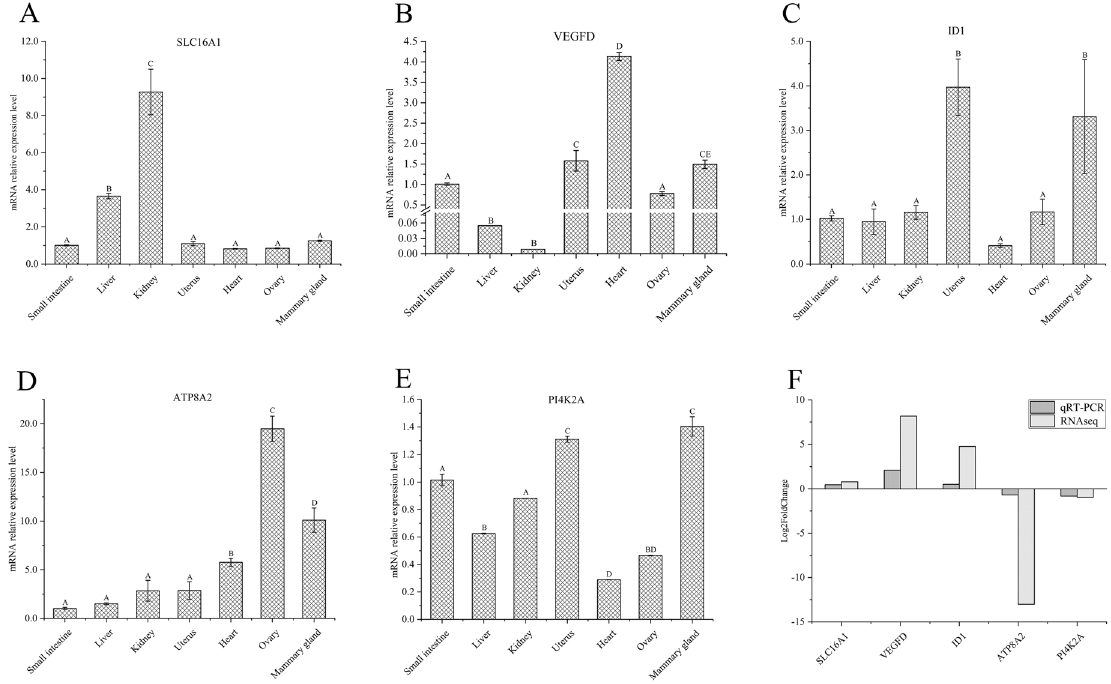
Figure 7. Expression levels of key candidate DEs in milk fat metabolism. ( A–E ) Expression levels of SLC16A1, VEGFD, ID1, ATP8A2 and PI4K2A genes in different tissues, respectively; ( F ) expression of SLC16A1, VEGFD, ID1, ATP8A2 and PI4K2A genes in BMECs of high and low milk fat groups. Different capital letters indicate significant